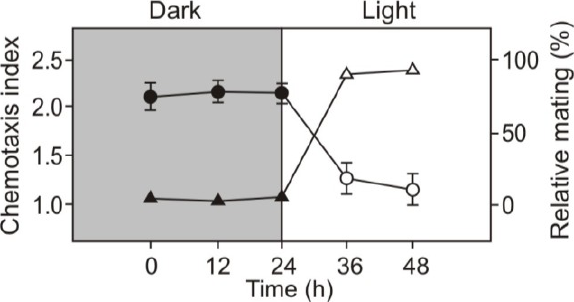
Figure 3. Chemotactic responses of pregametes ( ● ) and gametes obtained from pregametes ( ○ ) towards 5 mM nitrite. Vegetative cells of mt − were resuspended in TAP-N at time 0. The percentage of mating (Δ) is given for a comparison. At the times indicated, cells were mixed with an excess of sexually competent mating partner, and incubated in the dark. After 1h, the cells were fixed by the addition of glutaraldehyde and relative mating was determined as described in the Experimental Section. Data are means ± SD of triplicate determination from a representative